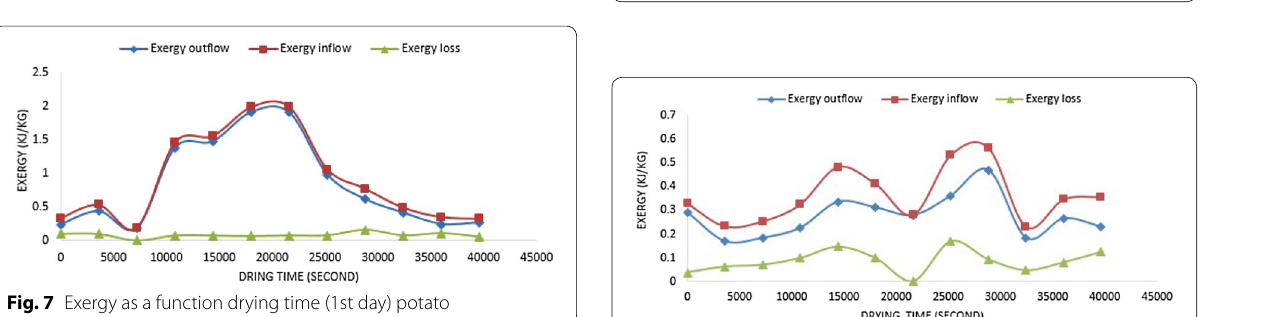
Fig. 10 Exergy as a function drying time (1st day) onion